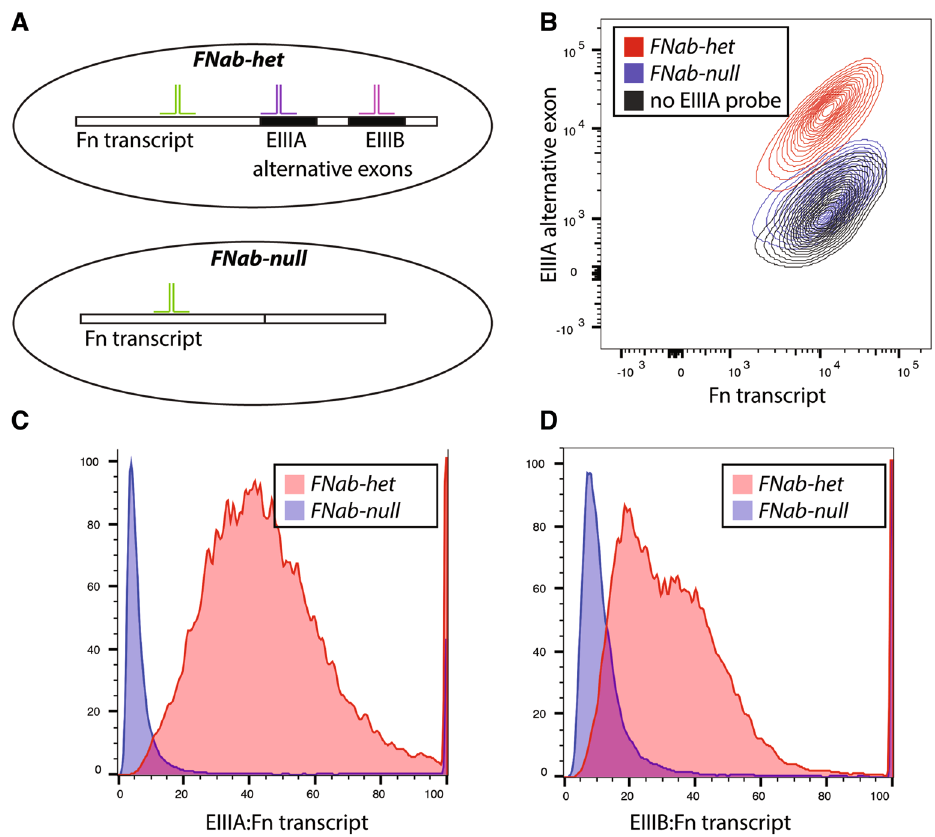
Figure 1. RNA-hybridization assay to measure inclusion of fibronectin alternative exons in individual endothelial cells. ( A ) Schematic showing binding of probes to transcripts containing EIIIA (from FNab-het cells) or not (from FNab-null cells). Probes to the constitutive region of FN bind to both transcripts (green), but probes to EIIIA (purple) or EIIIB (pink) binds only to these alternatively spliced exon (black region of FN transcript) when they are included in cells. ( B ) Fluorescent flow cytometry plot showing fluorescence detected in all cells for the FN probe (x-axis), but only detected for the EIIIA probe (y-axis) in cells expressing FN with EIIIA (red). Signal is absent when no EIIIA probe is included (but fluorescent detection is still performed, black), or when cells do not produce the EIIIA inclusive FN transcript (blue). ( C,D ) Ratio of signal from EIIIA probe ( A ) or EIIIB probe ( B ) to total FN probe from flow cytometry as in ( B